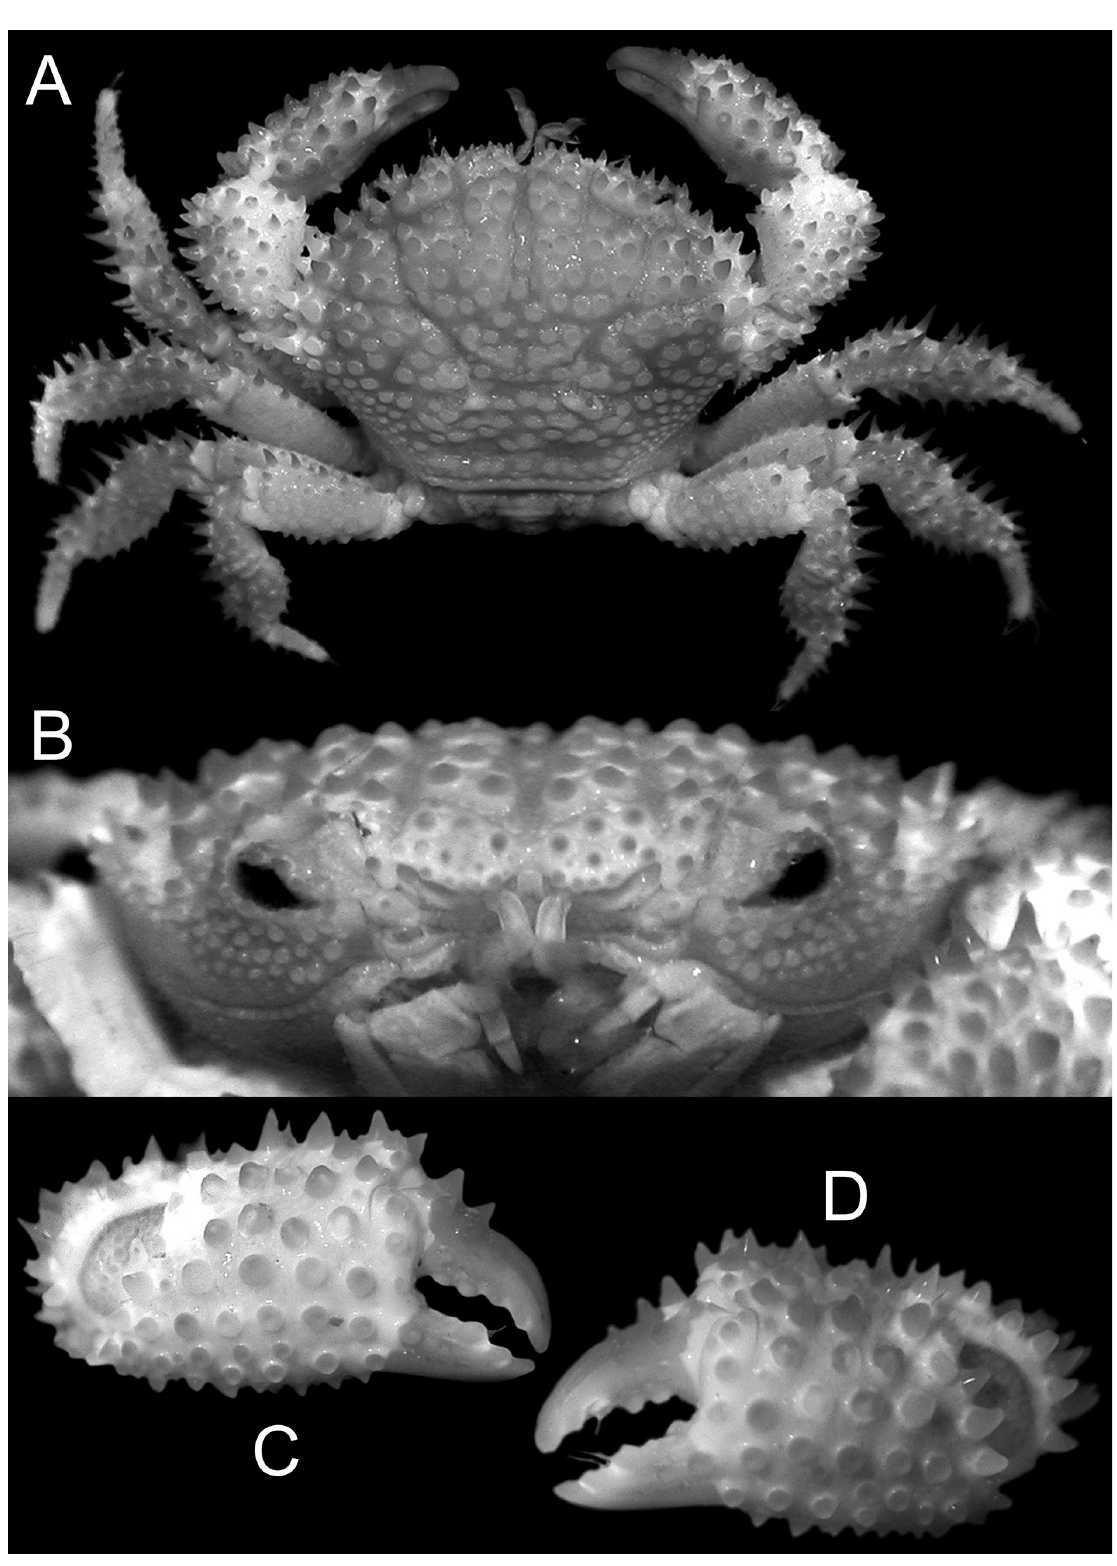
Fig. 3. Actaea grimaldii sp. nov., paratype, ♀, 10.2 × 7.8 mm (ZRC, ex MNHN IU 2013-1245), Papua New Guinea. A . Dorsal view of habitus. B . Frontal view of carapace. C . Outer view of right chela. D . Outer view of left